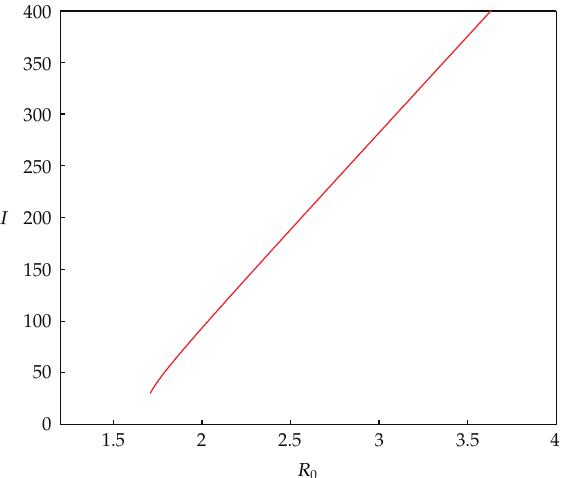
Figure 2: The diagram of I ∗ , I 2 versus R 0 when I 0 (cid:7) 30, A (cid:7) 100, β 1 (cid:7) 0 . 01, β 2 (cid:7) 0 . 01, γ (cid:7) 0 . 01, d (cid:7) 0 . 9, (cid:7) 1 . 6889, p (cid:7) 1 . 7882, p (cid:7) 1 . 7074, where (cid:5) iii (cid:6) of Theorem 2.2 holds. The bifurcation at (cid:4) (cid:7) 0 . 01, r (cid:7) 1, p 0 1 2 (cid:7) 1 is forward, and (cid:5) 1.4 (cid:6) has a unique endemic equilibrium for R R 0